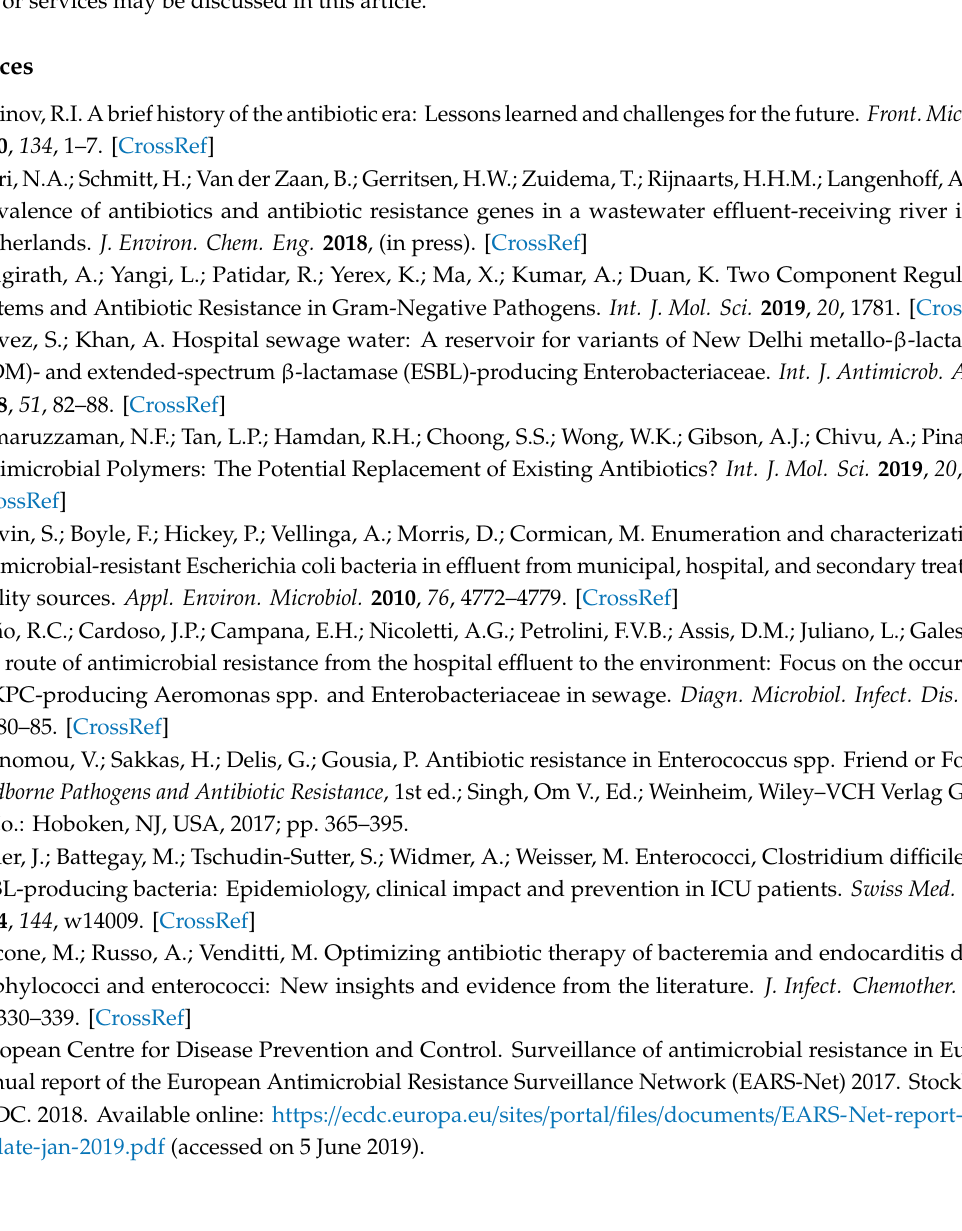
spp., Table S3: Antibiotic resistance profile of Escherichia coli . Table S4: Antibiotic resistance profile of Klebsiella pneumoniae . Table S5: Antibiotic resistance profile of Pseudomonas